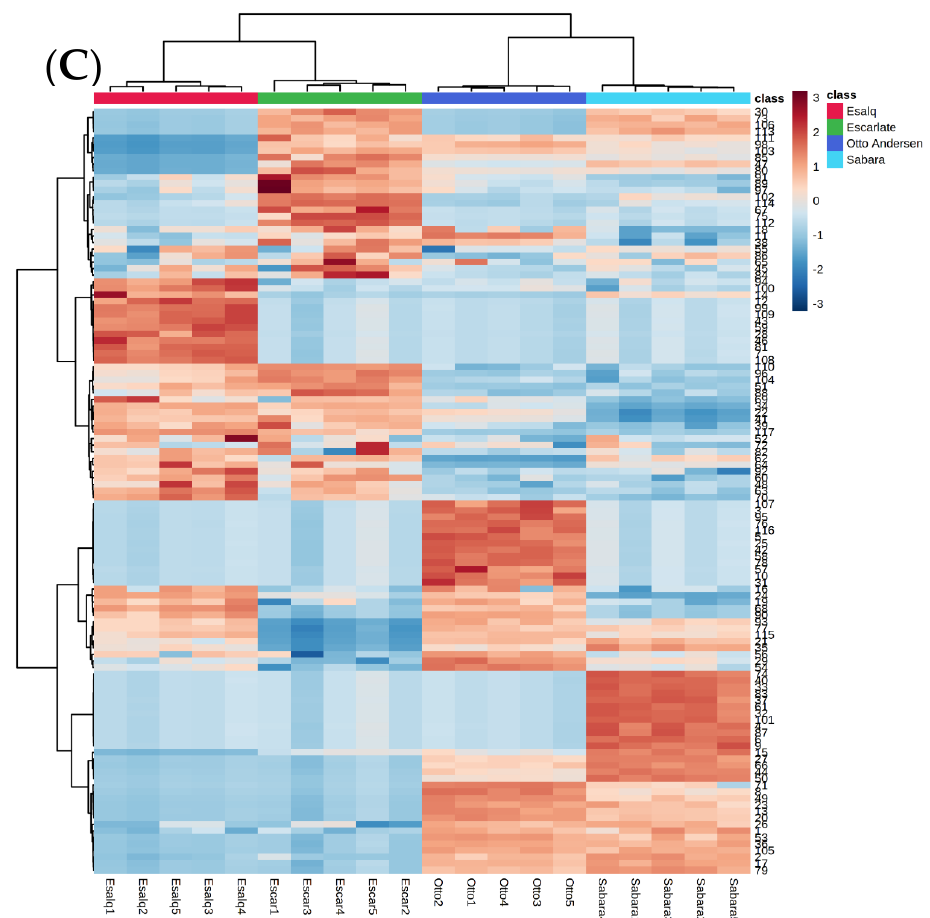
Figure 1. Volatile compound profiles produced by ‘Sabará’ ( Plinia jaboticaba ), ‘Escarlate’ ( Plinia phitrantha × Plinia cauliflora) , ‘Otto Andersen’ ( Plinia cauliflora ), and ‘Esalq’ ( Plinia phitrantha ) jabuticabas: ( A ) Partial least squares-discriminant analysis (PLS-DA), ( B ) PLSDA loadings, and ( C ) heatmap. The numbers in Figure 1B,C correspond to the code of compounds listed in Table 1. The separation of clusters is shown in detail in Table S2.